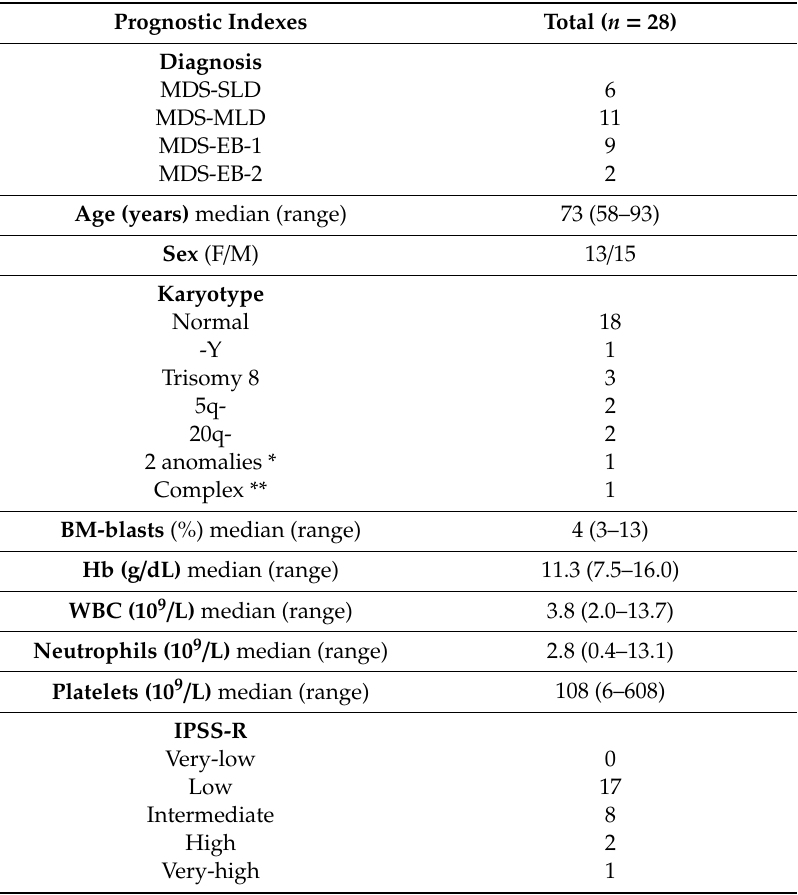
Table 1. Patient